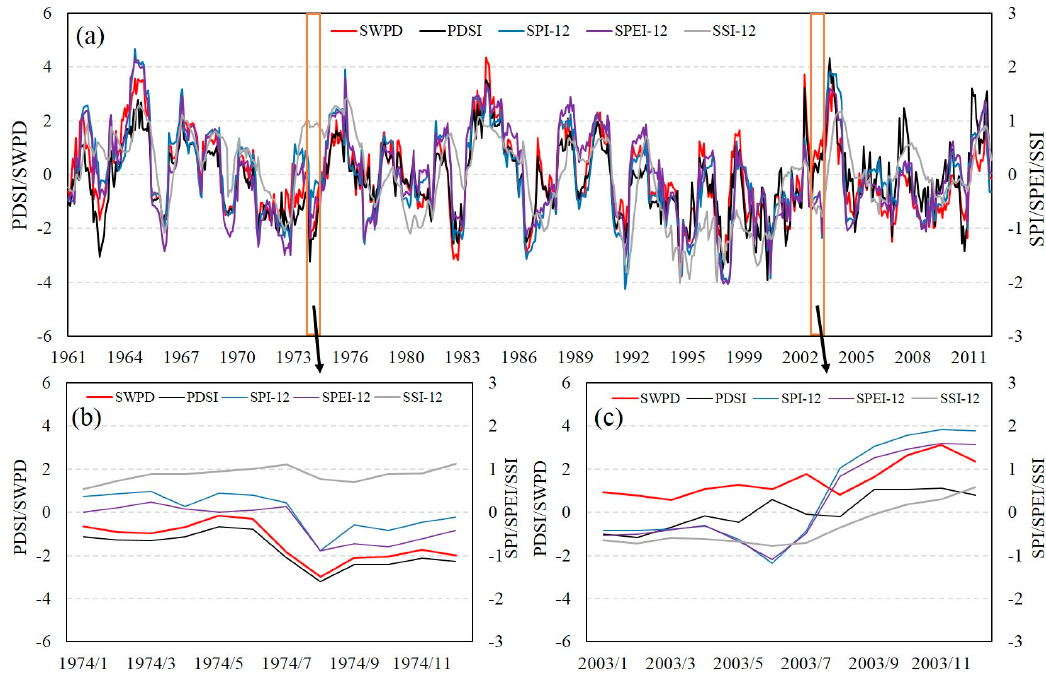
Figure 4. ( a ) Basin-averaged monthly PDSI/PDSI_SWAT compared with SPI-12, SPEI-12 and SSI-12 during 1961–2012; ( b ) Partial enlarged drawing during 1974 of Figure 4a; ( c ) Partial enlarged drawing during 2003 of Figure 4a.